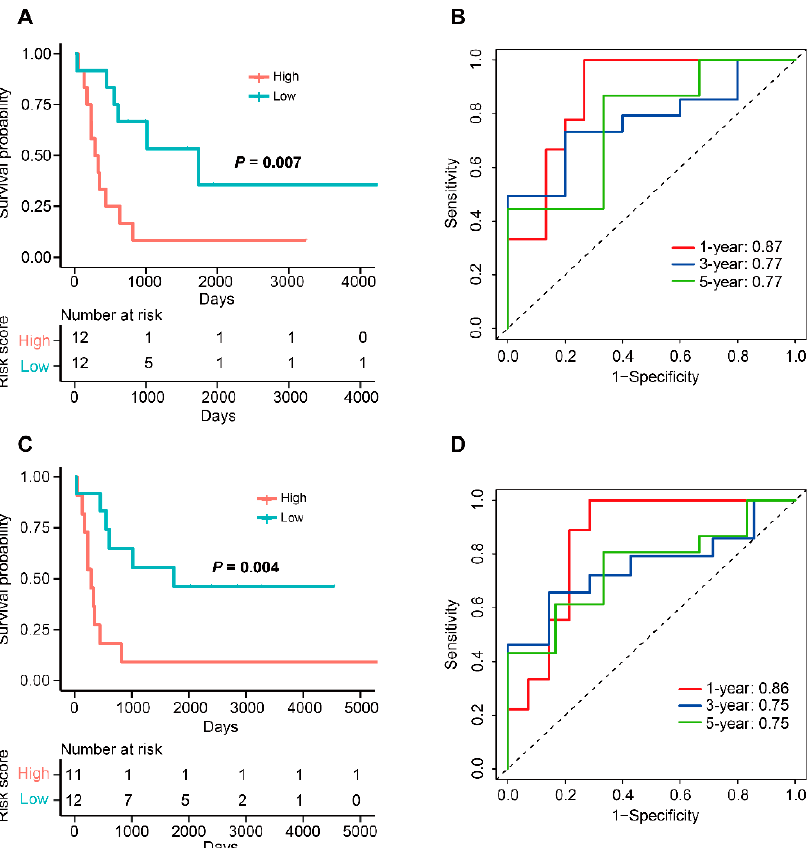
Figure 19. Validation of this TME-related signature in two external datasets. ( A ) KM curves of OS for patients in the high- and low-risk groups in GSE10927. ( B )Time-ROC curve to predict the OS at year 1, 3, and 5 in GSE10927. ( C ) KM curves of OS for patients in the high- and low-risk groups in GSE33371. ( D )Time-ROC curve to predict the OS at year 1, 3, and 5 in GSE33371.